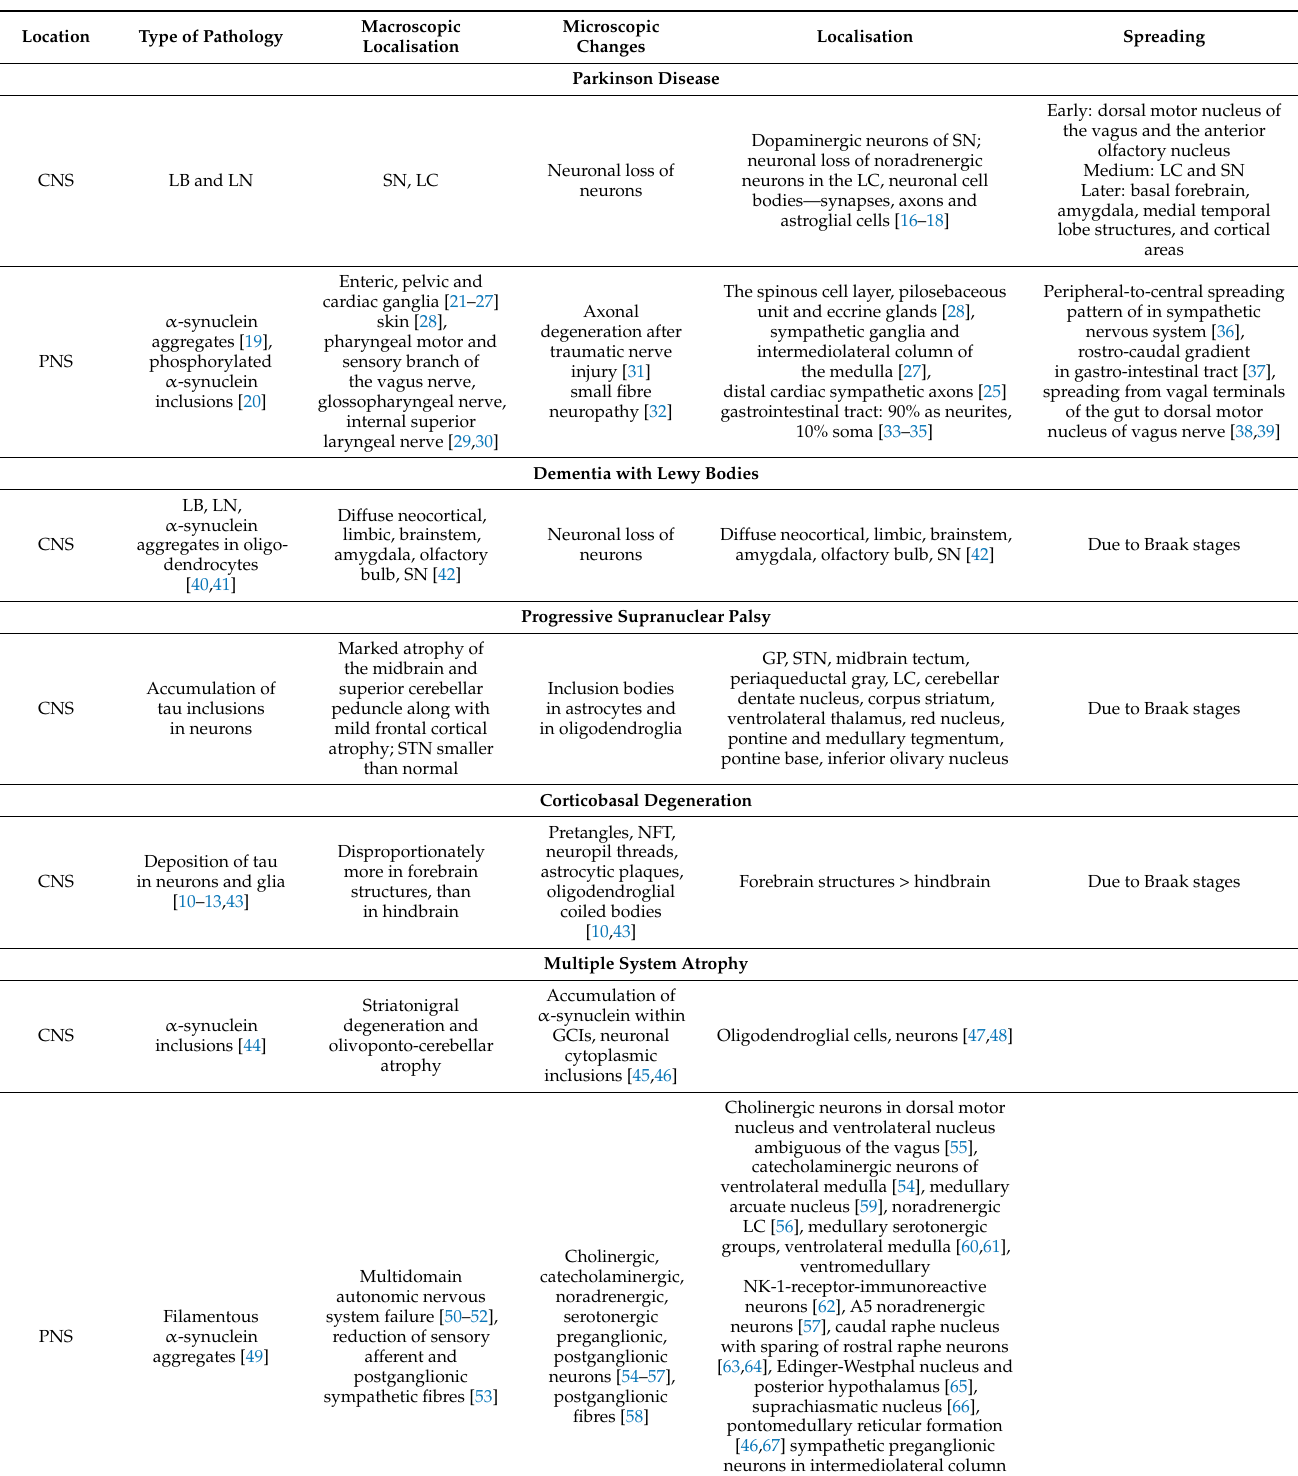
Table 1. Main neuropathological features of the different